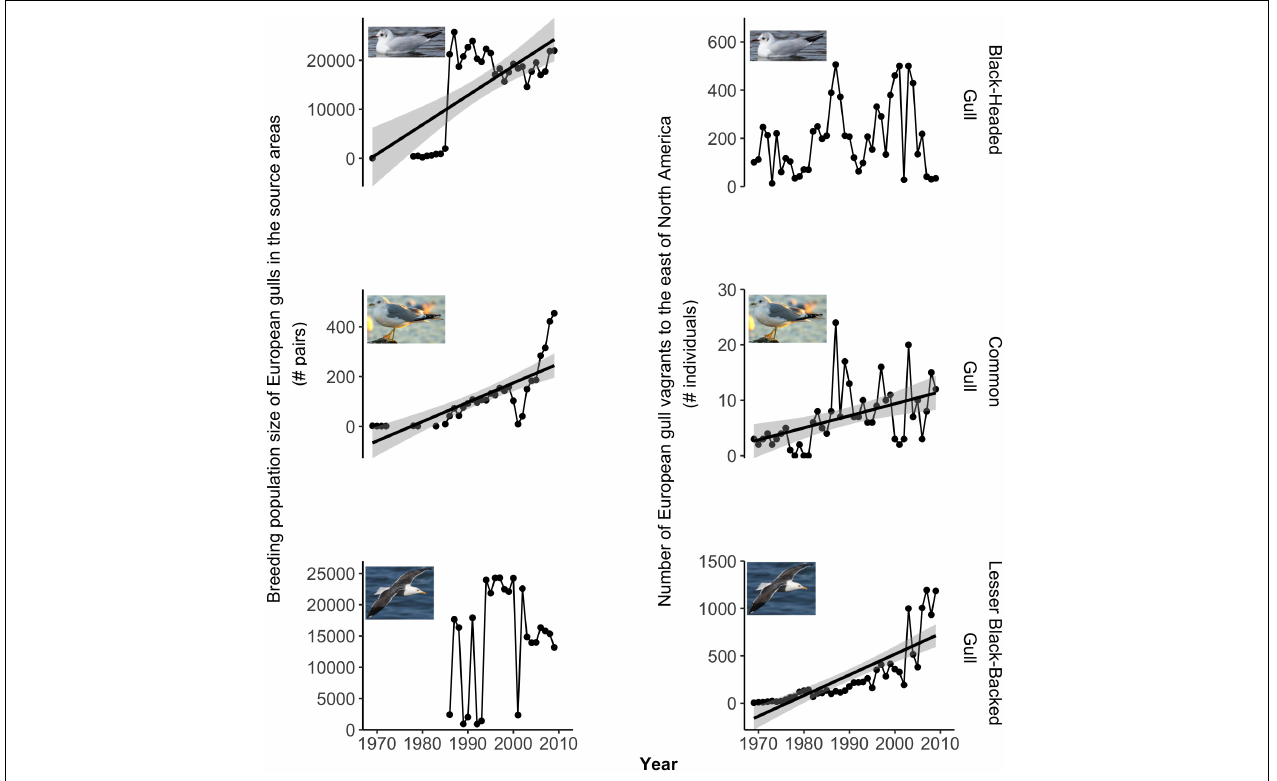
FIGURE 2 | Temporal trends for the European gulls. Left column: Breeding population size (1969–2009). Right column: Number of vagrants reported in eastern North America (1970–2010). Note that the y -axes have different